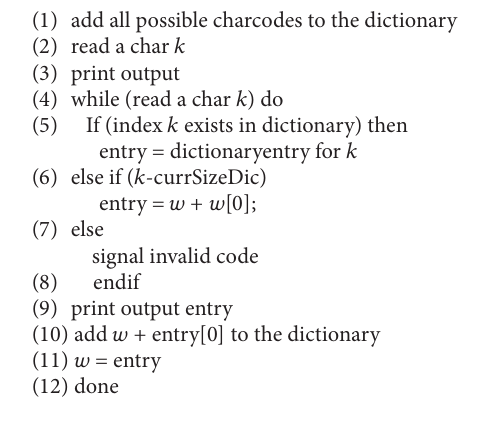
Algorithm 3: Text decompression algorithm.